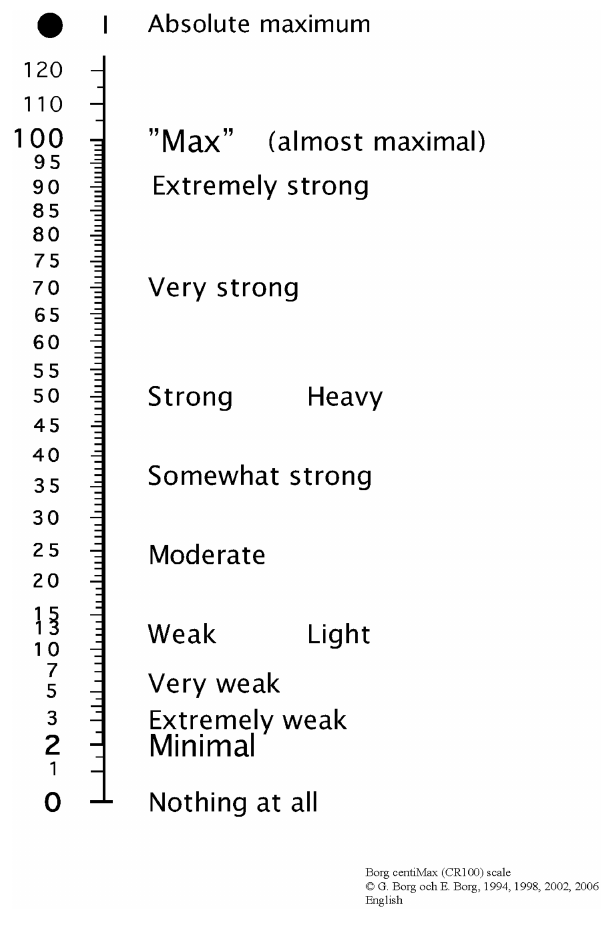
FIGURE 2 |The Borg CR100 scale ® . For users of the scale the latest version and instructions are provided by